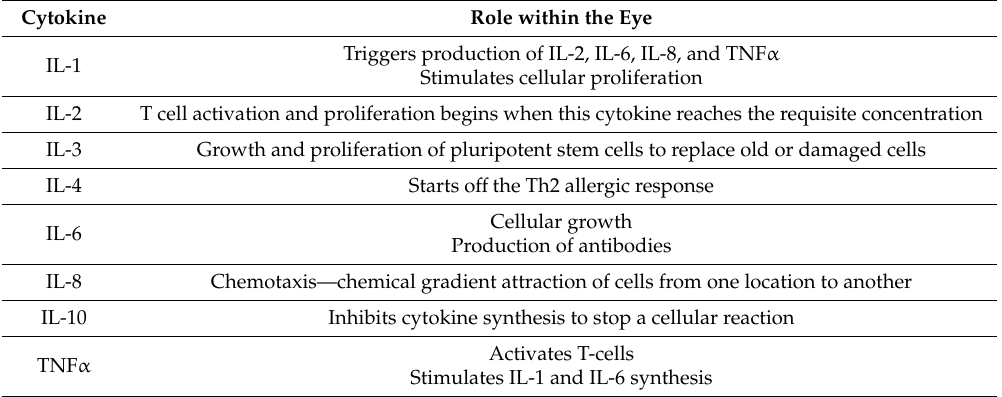
Table 3. Regulatory and inflammatory cytokines present in varying concentrations on the